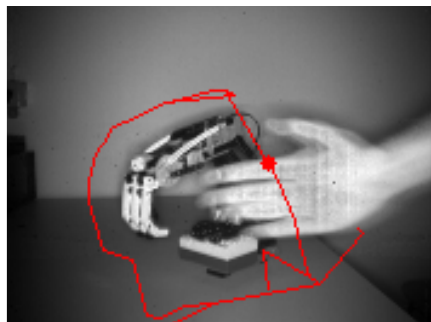
Fig. 12. Detected